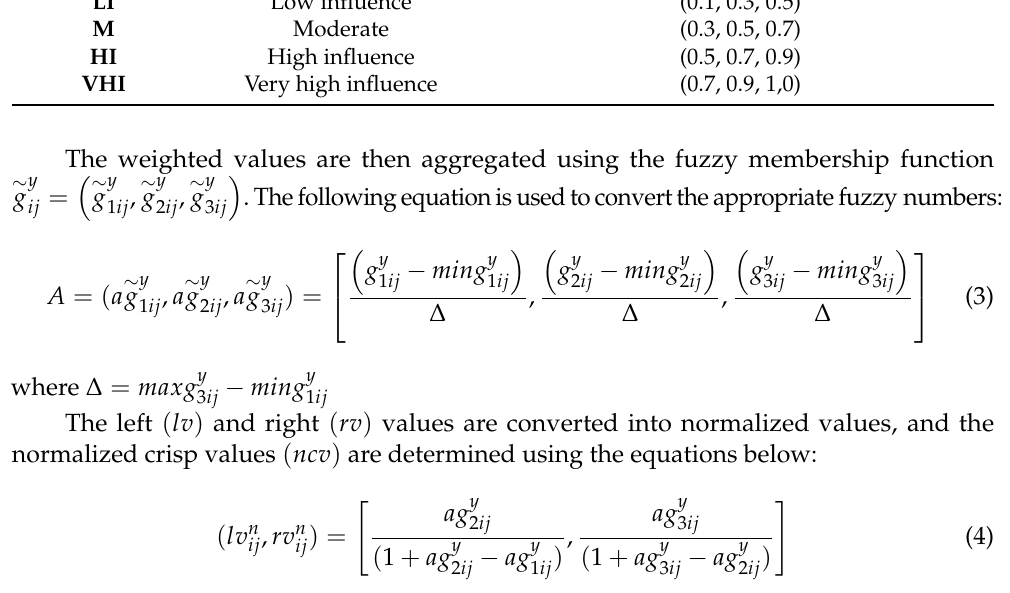
Table 2. FDEMATEL linguistic terms’ transformation table. Scale Linguistic Preferences Corresponding Triangular Fuzzy Numbers VLI Very low influence (0.0, 0.1, 0.3) LI Low influence M Moderate (0.3, 0.5, 0.7) HI High influence (0.5, 0.7, 0.9) VHI Very high influence (0.7, 0.9,